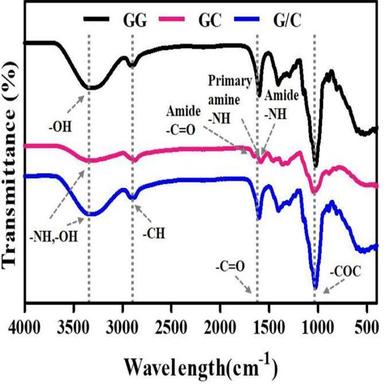
FT-IR analysis of GG, GC and G/C hydrogel in the wavelength range of 400–4000 cm−1 .